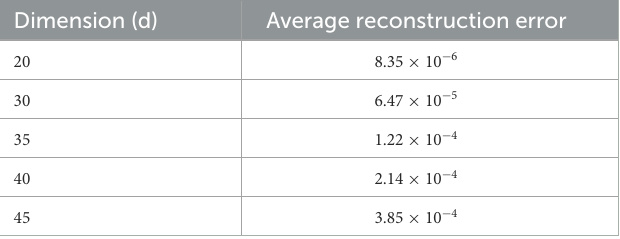
TABLE 1 The table indicates the reconstruction error values as a function of the dimension in the neighborhood of the chosen optimal dimension. Dimension (d)